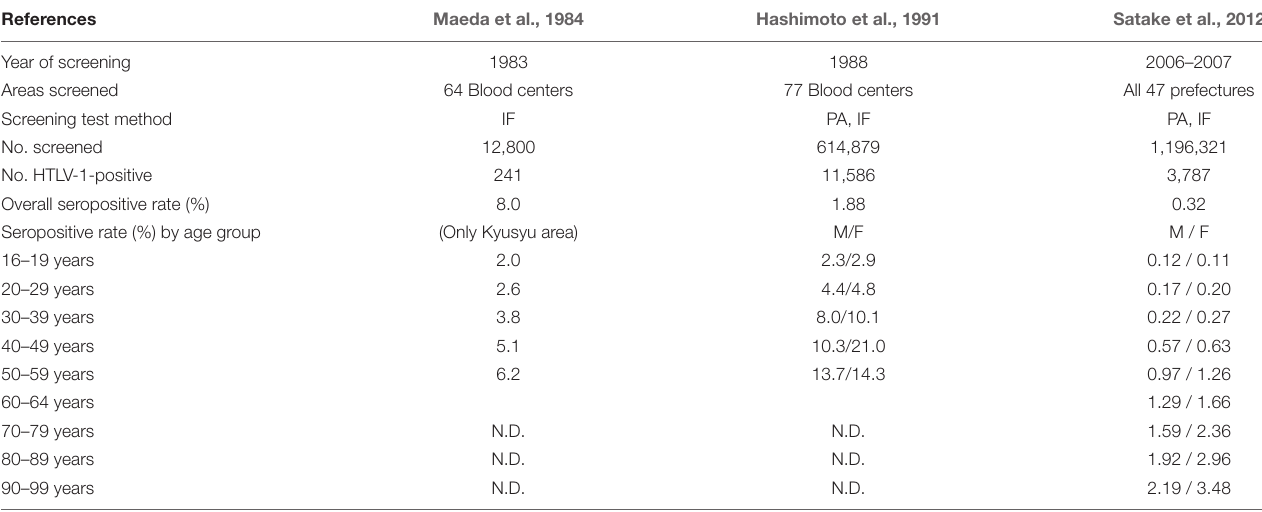
TABLE 1 | HTLV-1 seroprevalence among Japanese blood donors in